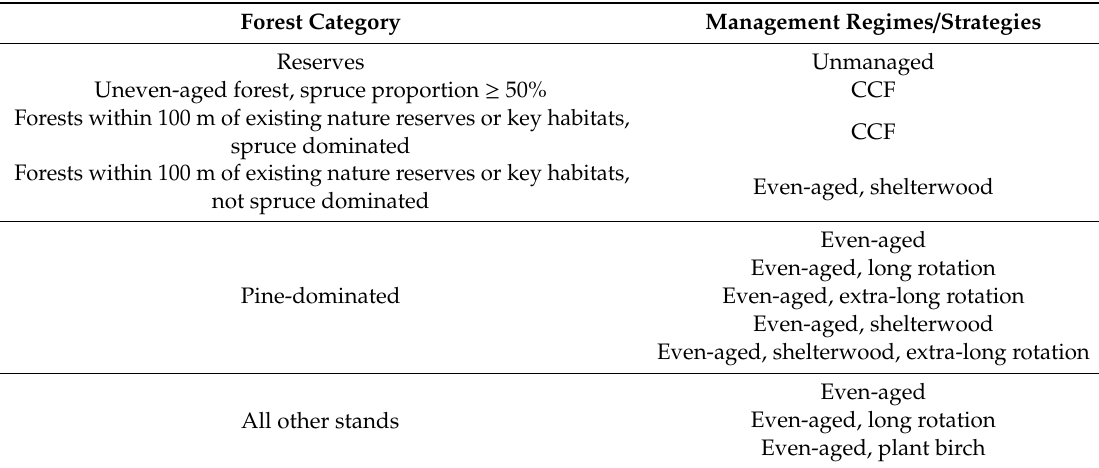
Table A2. Management strategies for di ff erent forest categories. For all strategies, a maximum number of 10 treatment schedules was